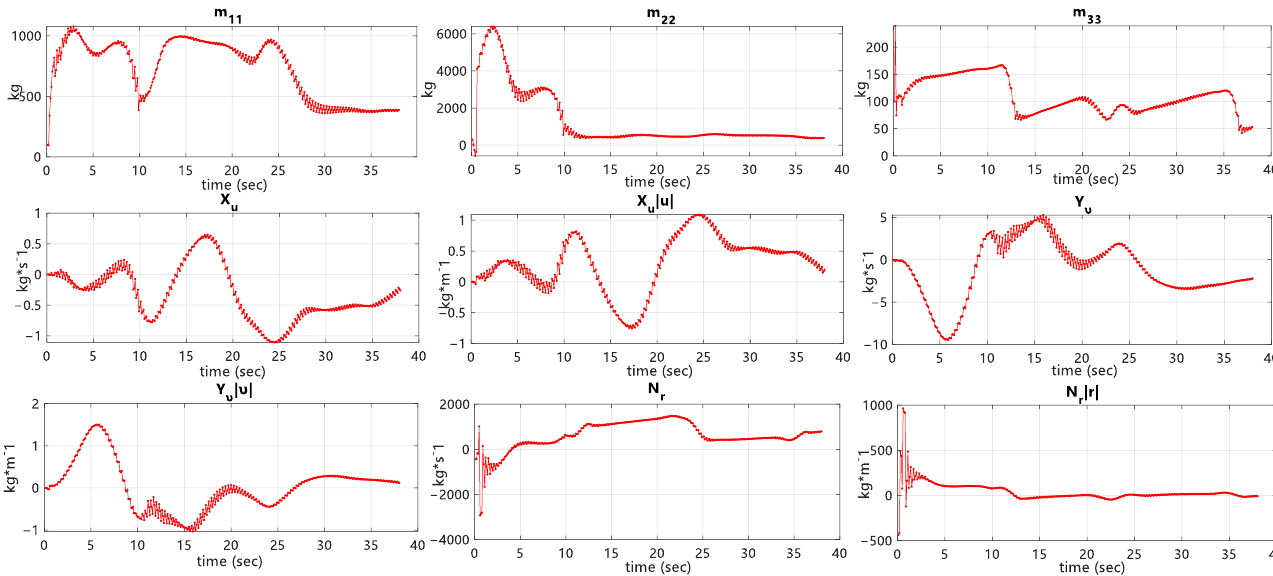
Figure 8. Identification of hydrodynamic derivatives based on the original data.